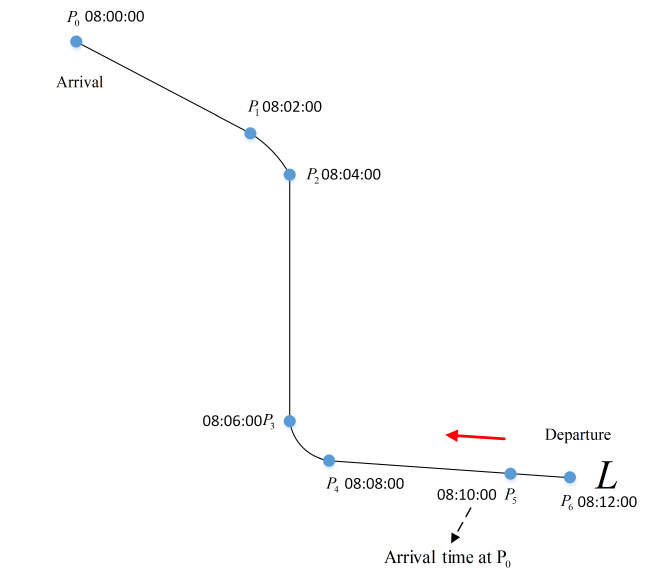
Figure 4. Arrival time of the 4D